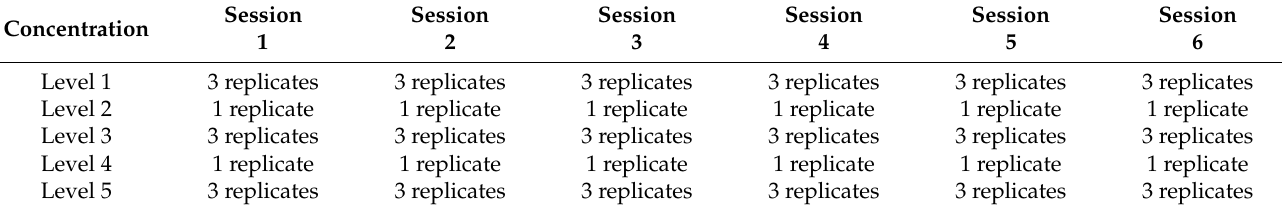
Table A5. Sample replicate scheme used to generate data for Sample Linearity and Reproducibility.